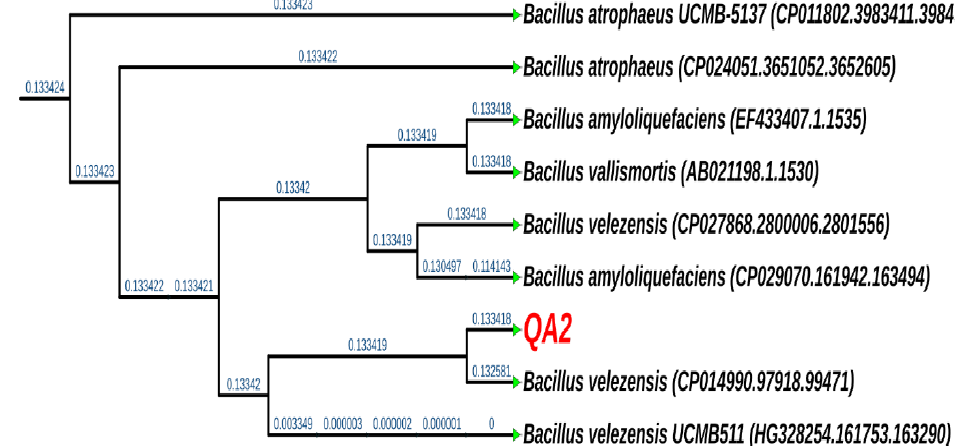
Figure 4. Phylogenetic tree of QA2 strain based on PHYLIP Neighbor-Joining method of the 16S rRNA gene sequences using UGENE. The 16S rRNA gene sequences and tree of closely related species were obtained from the SILVA database.